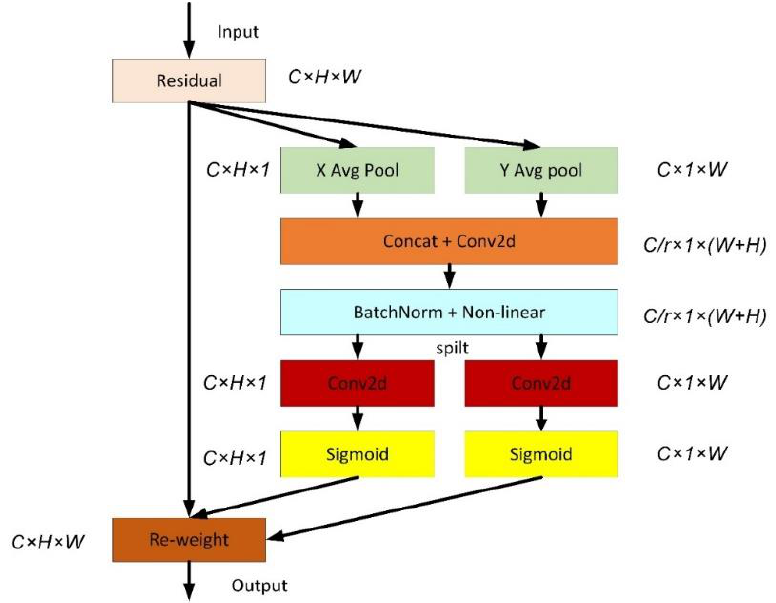
Figure 2. Coordinated